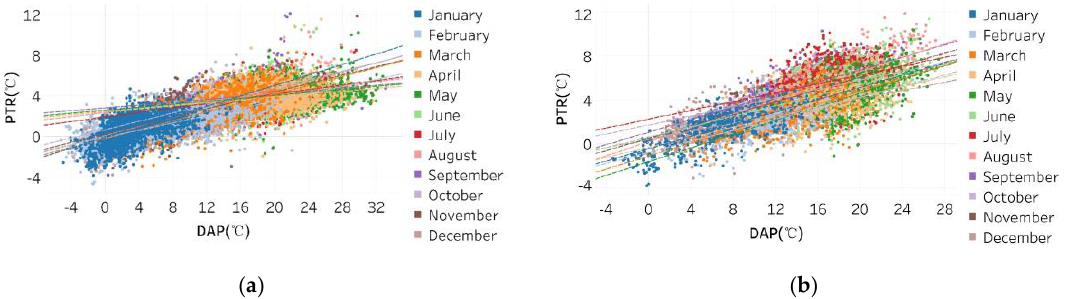
Figure 10. Relationship between pouring temperature rise (PTR) and difference between air and pouring temperatures (DAP): ( a ) Baihetan dam; ( b ) Wudongde dam.